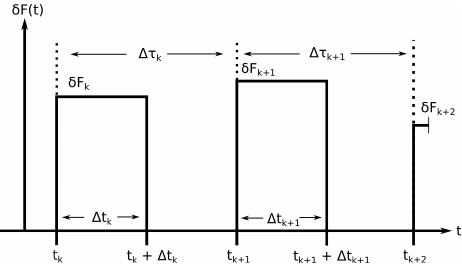
Figure 10. The mistral forcing as a pulse function used to solve Eq. (14). k corresponds to the event, and δF k corresponds to the forcing strength of the mistral event. (cid:49)t k corresponds to the dura- tion of the of the Mistral event, and (cid:49)τ k corresponds to the period between events, with t k denoting the start of event k